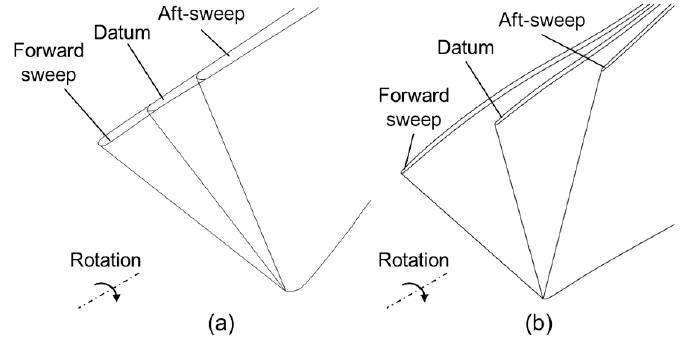
Figure 2. Sweep definition: ( a ) maintaining rest blade part and ( b ) maintaining relative blade angle and thickness distribution.